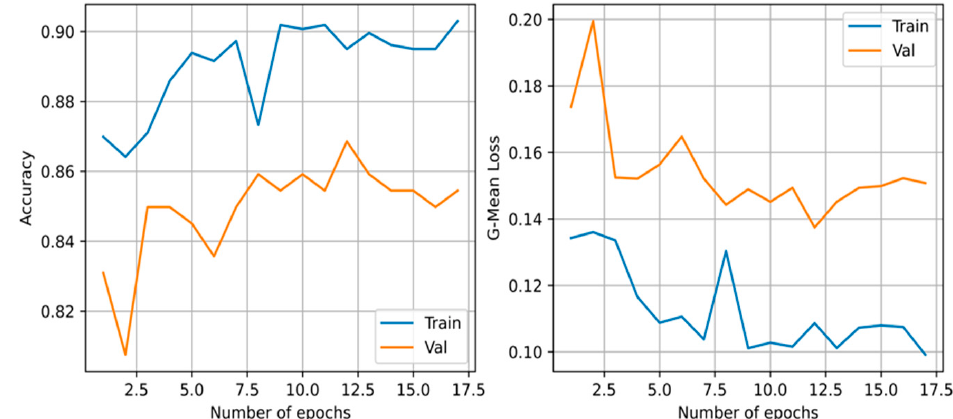
Figure 5. The geometric mean loss and accuracy of the training and validation set of the cascade correlation neural network during training.